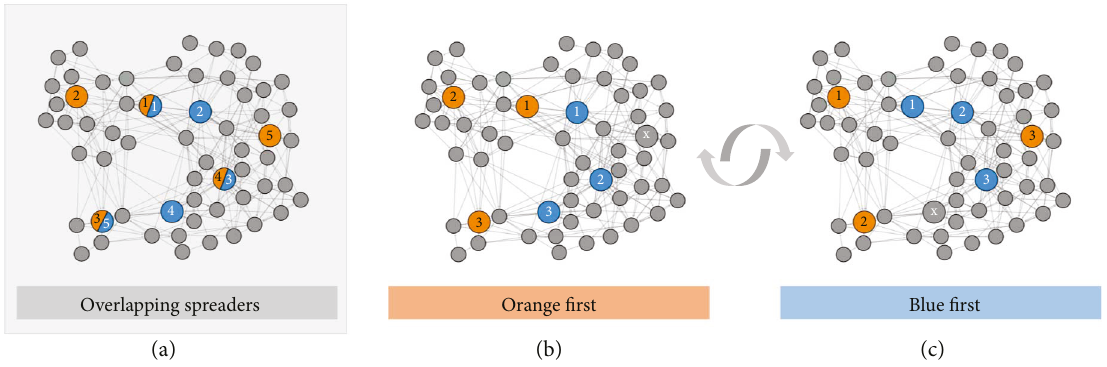
Figure 2: Example of the alternate opinion assigning approach in order to o ff er both competing ranking methods even chances of propagation. The coloured nodes marked with indices 1 – 5 represent the top 5 orange, respectively, blue spreaders, as determined by the two ranking methods. Moreover, some of these spreaders overlap ((a) e.g., 3/5 means 3rd best orange spreader and 5th best blue spreader), so we assign each spreader node one of two opinions (orange/blue) alternatively, starting with orange fi rst (b) then blue fi rst (c). As such, a simulation of orange versus blue ranking methods translates into two independent simulations, slightly favouring each method in turn. The assigning of opinion is always evenly distributed in terms of number of nodes, for example, 3 spreaders in this